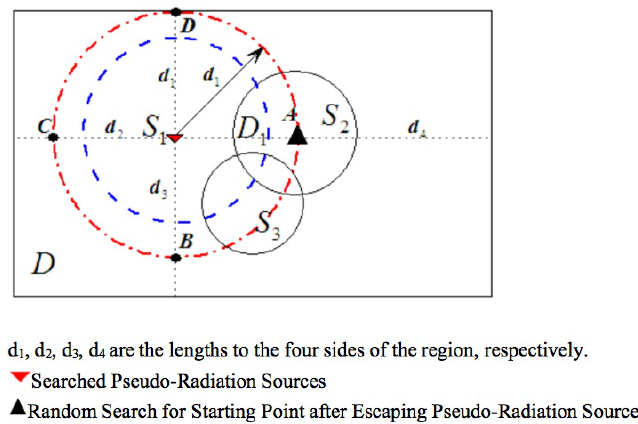
Fig. 8 Schematic diagram of improved markup random search